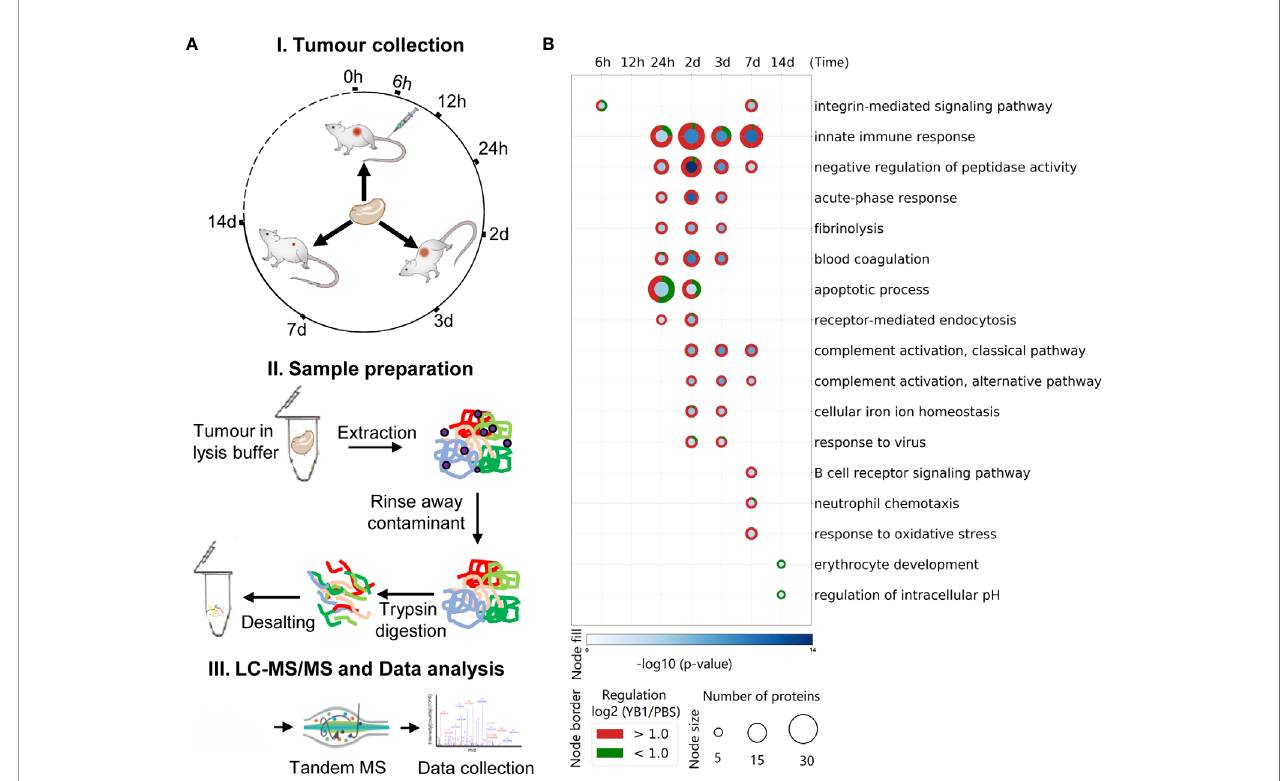
FIGURE 1 | Temporal proteome pro fi ling for exploring the anti-cancer mechanism of Salmonella YB1. (A) Experimental design and data analysis work fl ow of the tumor proteome. (I) Illustration of the tumor collection after Salmonella YB1 strain treatment at different time points. (II). General work fl ow of proteomic sample preparation process. (III) The work fl ow of MS-based quantitative proteomics and bioinformatics analysis. (B) GO term enrichment of differentially expressed tumor proteins. Selected enriched GO terms are depicted; all enriched GO terms can be found in Supplementary Table 1 . Node size and colors depict signi fi cance, [ – log10 ( p -value)] right-sided hypergeometric test, Bonferroni corrected) (blue shading) and number of proteins (Node size), respectively. n = 4 biologically independent